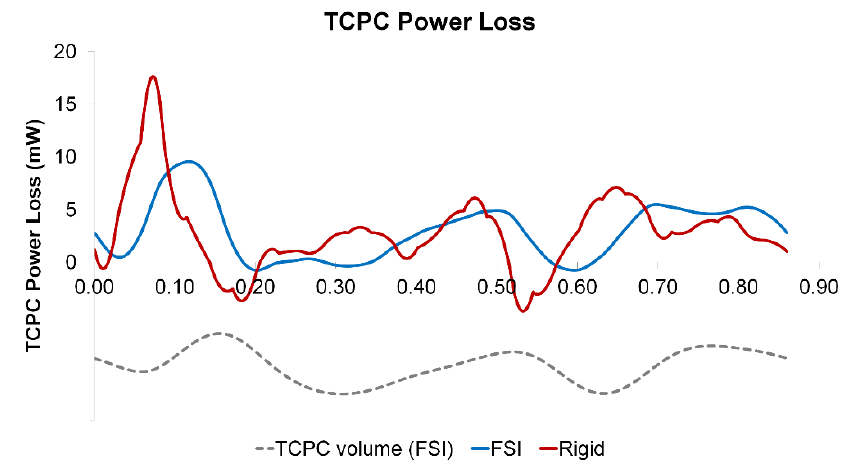
Figure 10. TCPC power loss waveforms of the rigid wall and fluid-structure interaction (FSI) simulations within a cardiac cycle. The waveform of the TCPC volume from the FSI simulation is shown simultaneously. TCPC: total cavopulmonary connection. Table 4. Comparison of pressure drop and TCPC power loss between the rigid wall and fluid- structure interaction (FSI) simulations over the cardiac cycle. TCPC: total cavopulmonary connection.